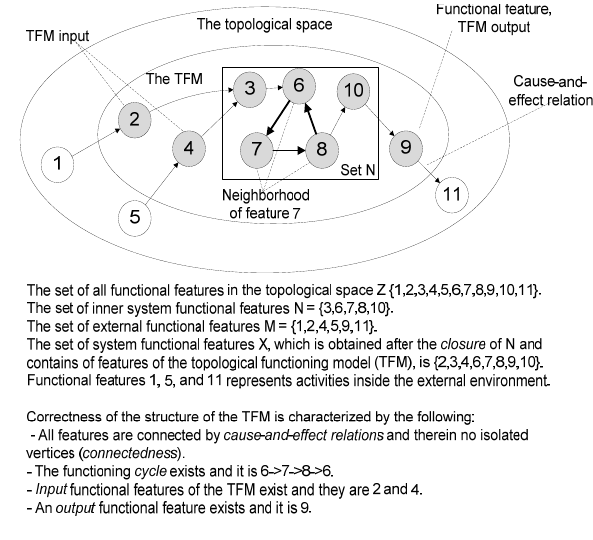
Fig. 1. An abstract topological functioning model and its properties.